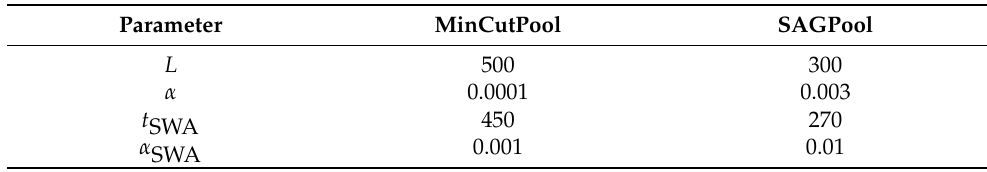
Table A4. The parameter settings for the graph-classification task on dataset PROTEINS. The baseline optimizer was Adam with weight-decay factor of 0.0005. The variable L denotes the total number of epochs, α is the learning rate of the Adam optimizer, α SWA is the constant learning rate used by SWA, and t SWA is the starting point to launch